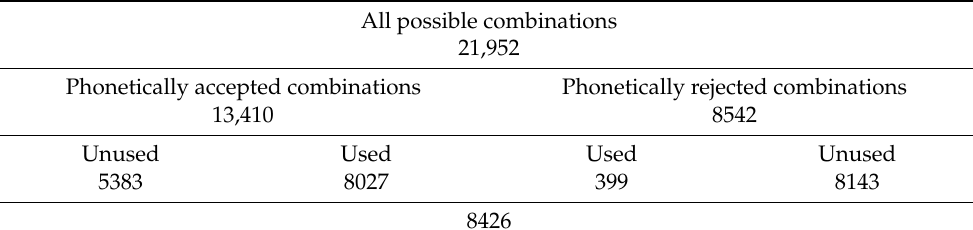
Table 3. Three-Letter Combinations